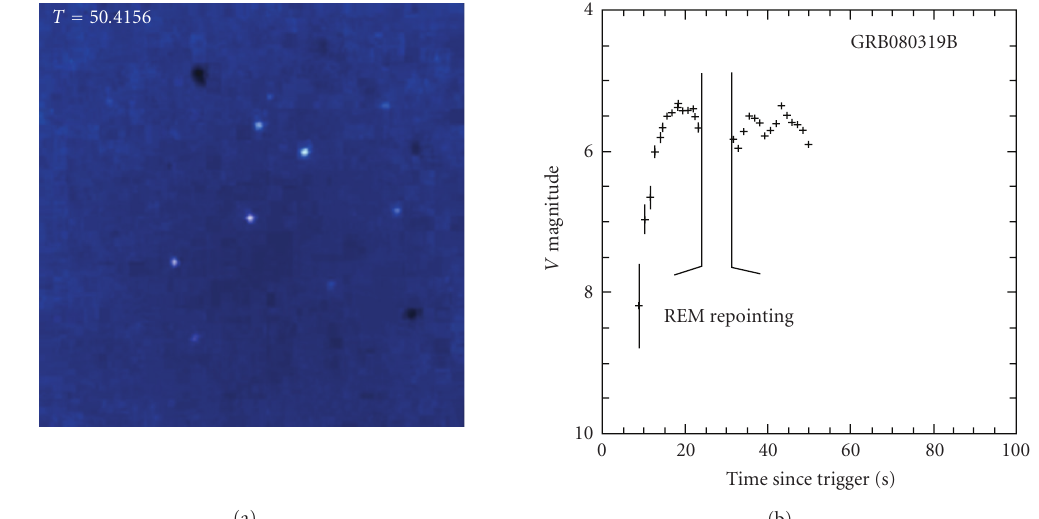
Figure 8: (a) A subframe of the wide field image centered on the optical transient 50 seconds after Swift trigger. The light curve (b) of GRB080319B measured by the TORTORA camera.